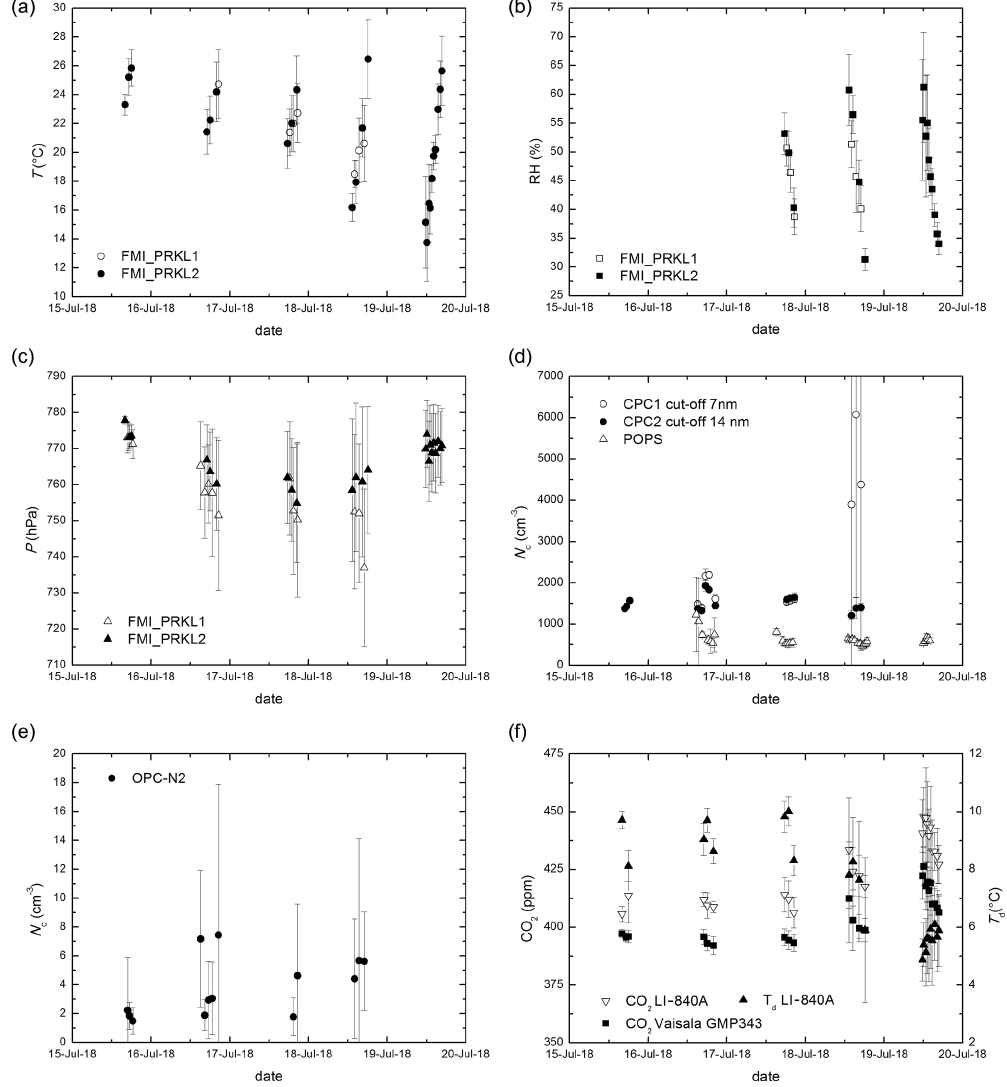
Figure 2. Overview of data collected in vertical profile: mean values with standard deviations as error-bars: (a) temperature, (b) relative humidity, (c) pressure, (d) total aerosol number concentration by CPCs and POPS (0.13–3µm) – note the elevated concentration measured by CPC1 characterizing the NPF event – (e) aerosol number concentration by OPC-N2 (0.3–18µm), and (f) CO 2 concentration by